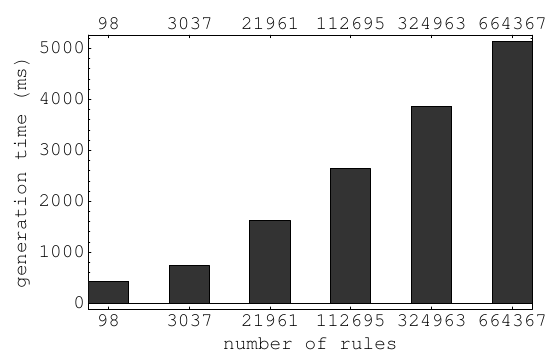
Figure 8. Time of rule generation.